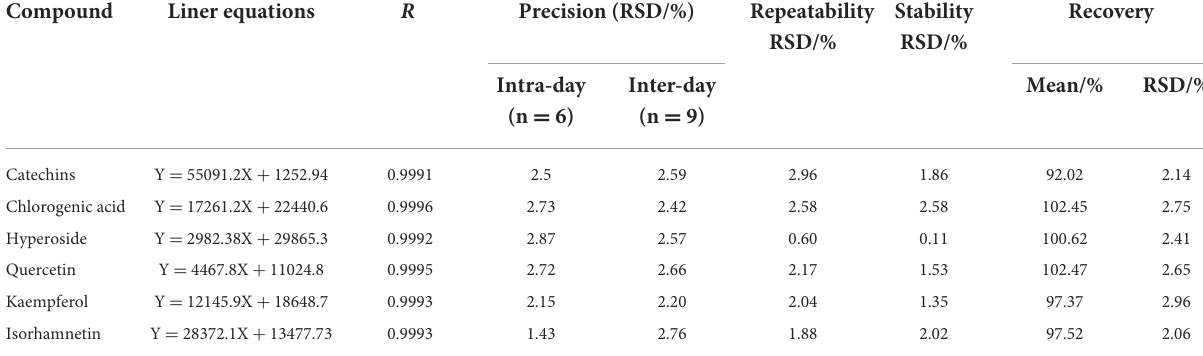
TABLE 2 Liner equations, precision, repeatability, stability, and average recovery rates of quantification of six components.